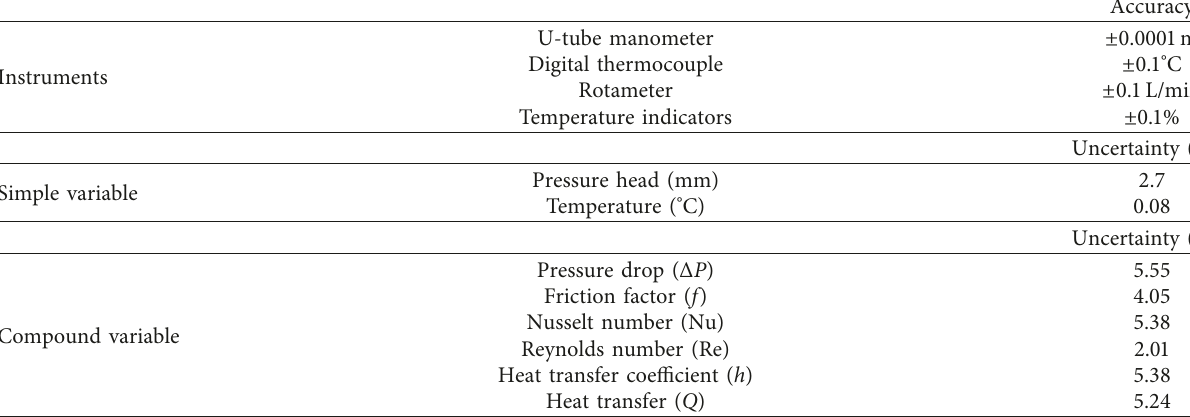
Table 2: Accuracy of the instruments.